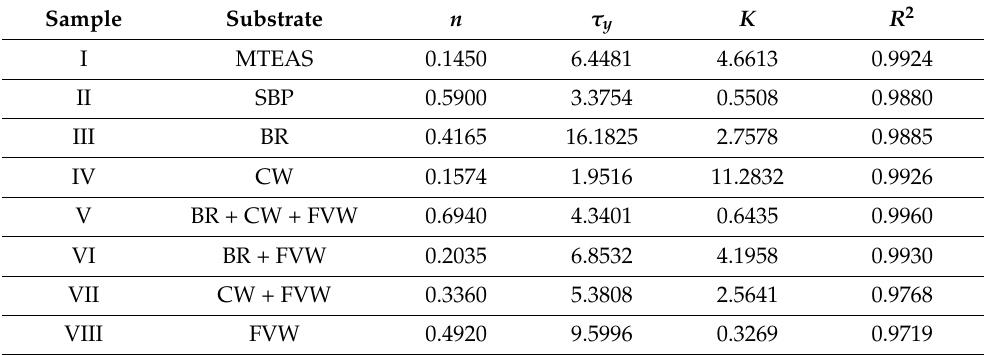
Table 6. Rheological parameters for the Hershel–Bulkley